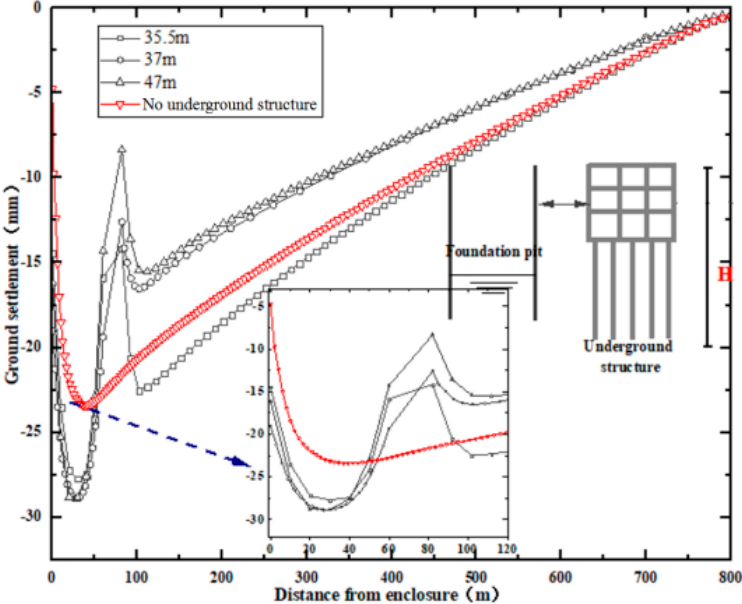
Figure 9. Distribution of ground settlement under different H .